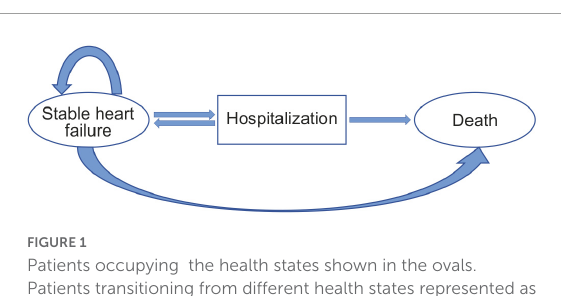
FIGURE1 Patients occupying the health states shown in the ovals. Patients transitioning from different health states represented as arrows based on the transition